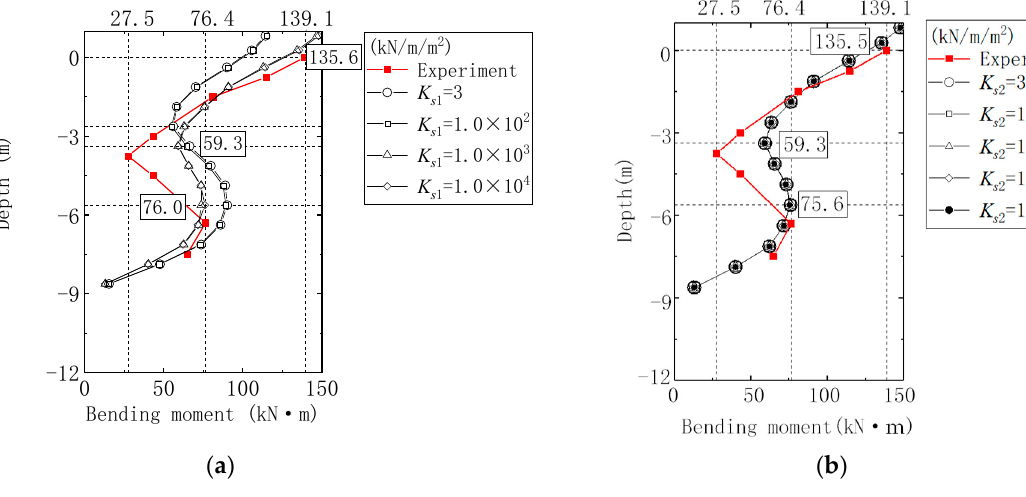
Figure 17. Influence of tangential stiffness on bending moment of Pile 1: ( a ) Change the value of tangential stiffness K s1 ; ( b ) Change the value of tangential stiffness K s2 .